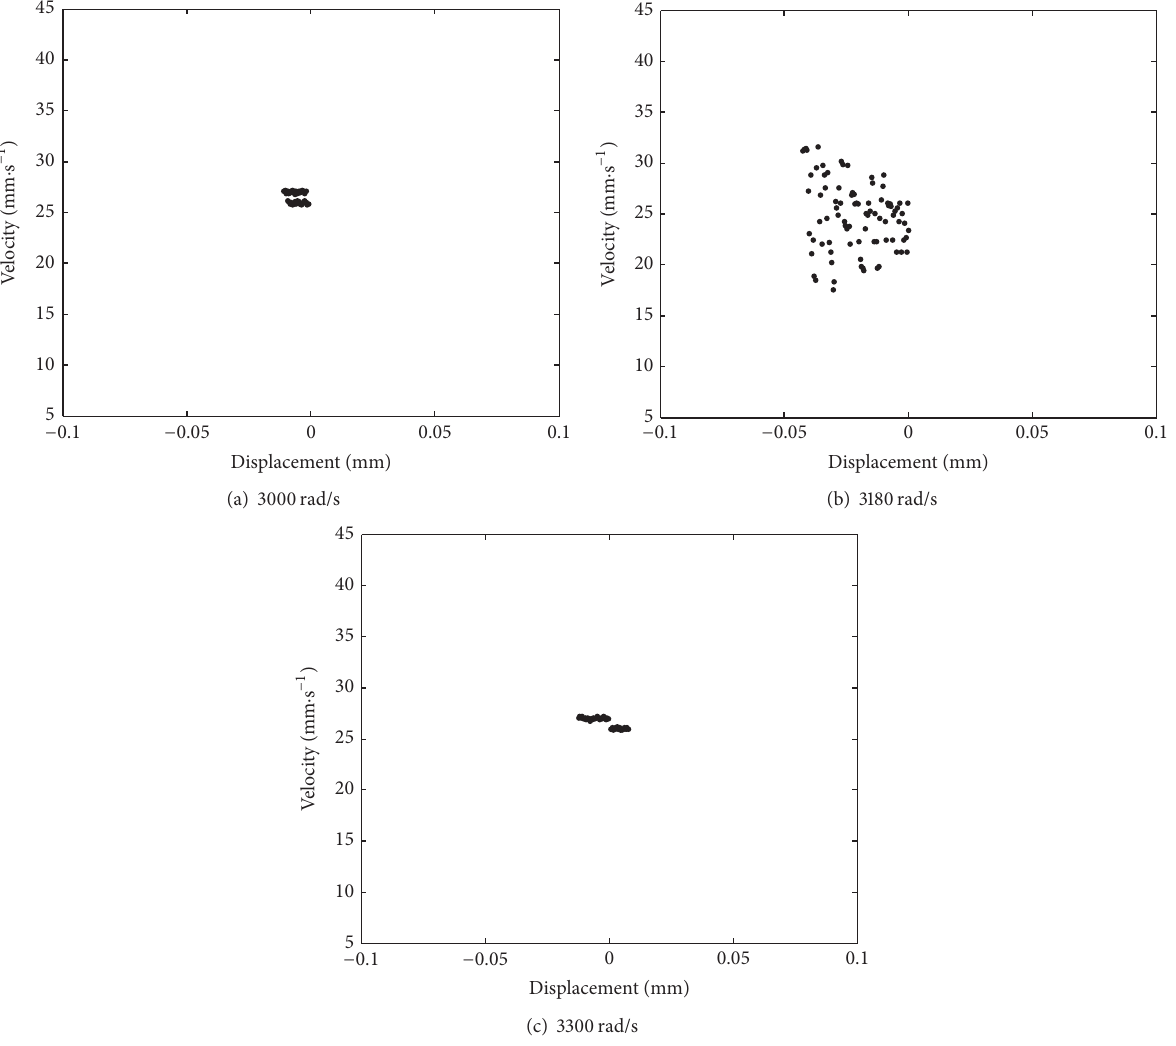
Figure 9: Poincar´e mapping of the rotor center in 𝑦